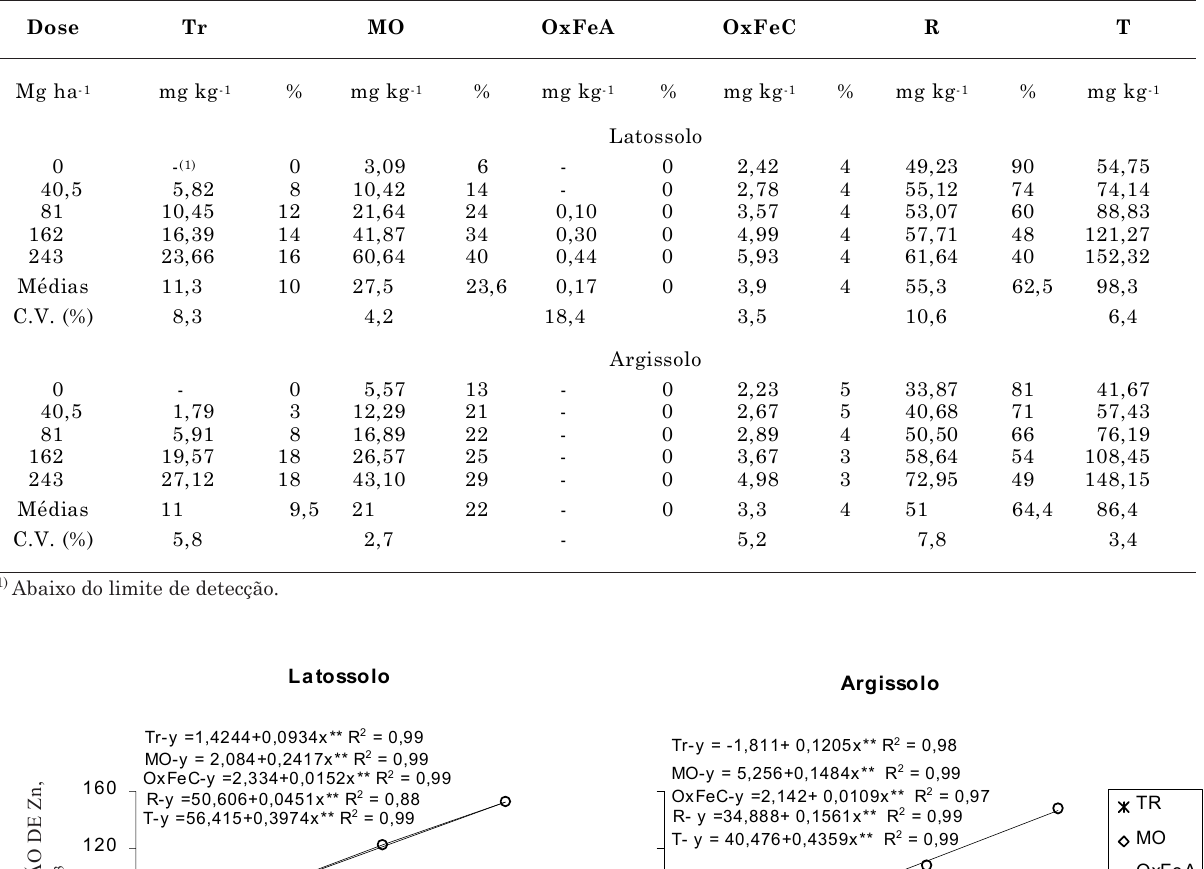
0,99R-y =50,606+0,0451x** R 2 T-y =56,415+0,3974x** R 2 =